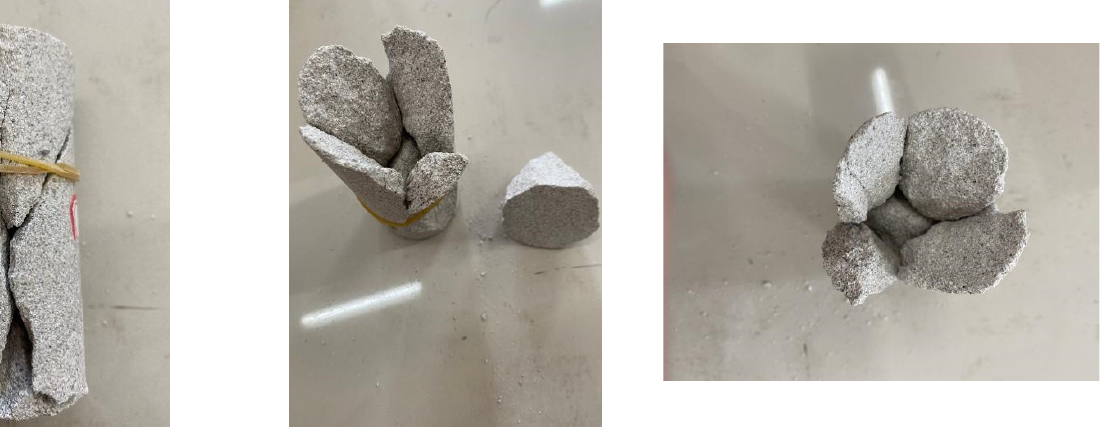
Figure 10. 600 °C sandstone specimens after damage. Figure 10. 600 ◦ C sandstone specimens after